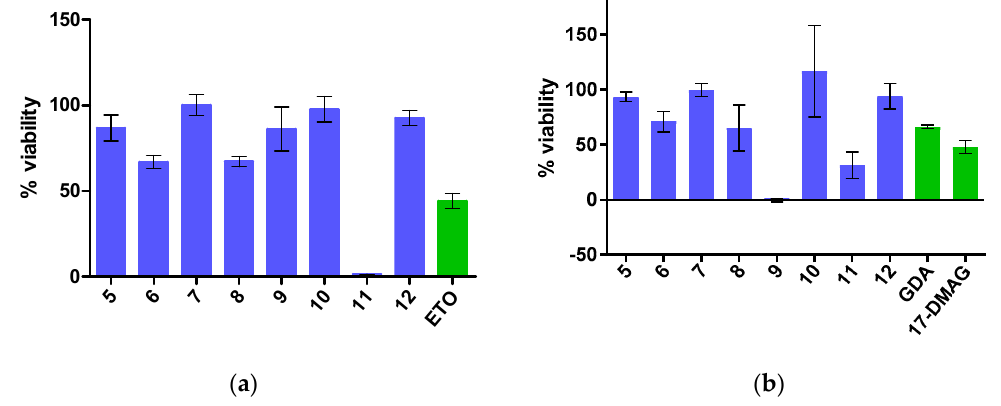
Figure 10. Cell viability of ( a ) Hep G2 and ( b ) MCF-7 cells in MTS assay after treatment with compounds 5 – 12 , and etoposide (ETO) at 50 μ M concentration or geldanamycin (GDA) at 10 nM concentration and 17-DMAG at 1 μ M concentration. Data are means ± SD of three independent experiments performed in triplicate.